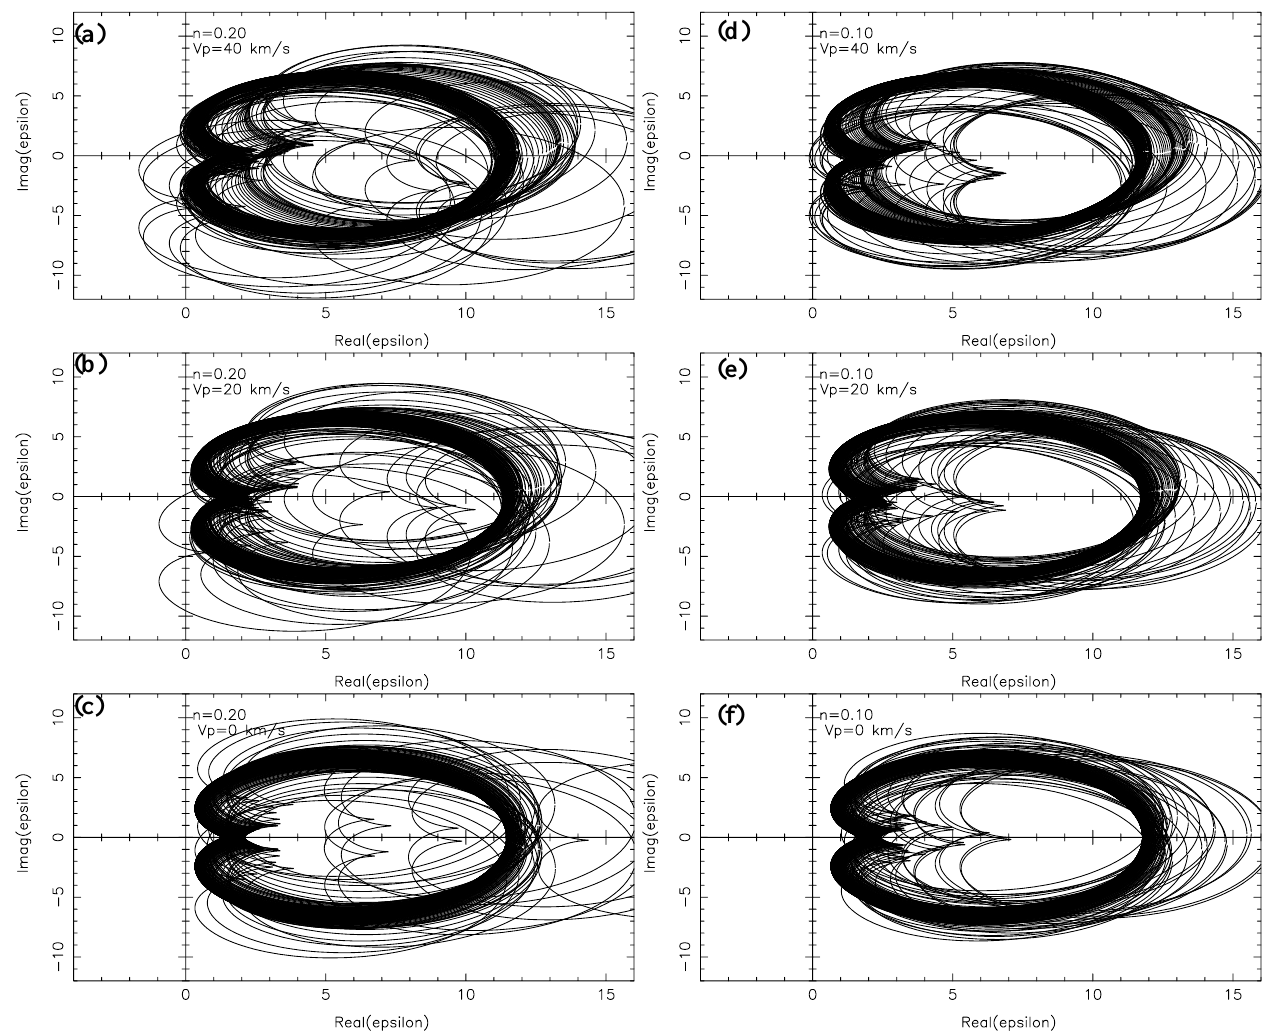
Fig. 9. The plasma dispersion curves C (cid:15) plotted in each panel for all positions: (a) n i ≡ 20% and V p =40km/s; (b) n i ≡ 20% and V p =20km/s; (c) n i ≡ 20% and V p =0km/s; (d) n i ≡ 10% and V p =40km/s; (e) n i ≡ 10% and V p =20km/s; (f) n i ≡ 10% and V p =0km/s.